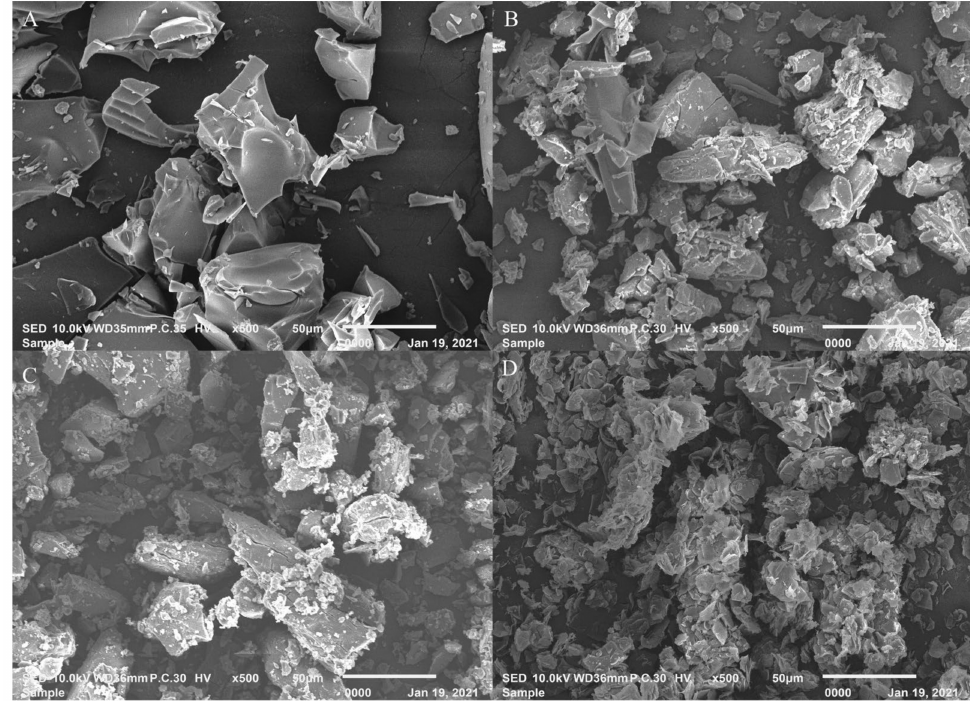
Figure 7. Scanning electro microphotographs of G-Re ( A ), γ -CD ( B ), G-Re- γ -CD PM ( C ), and G-Re- γ - CD IC ( D